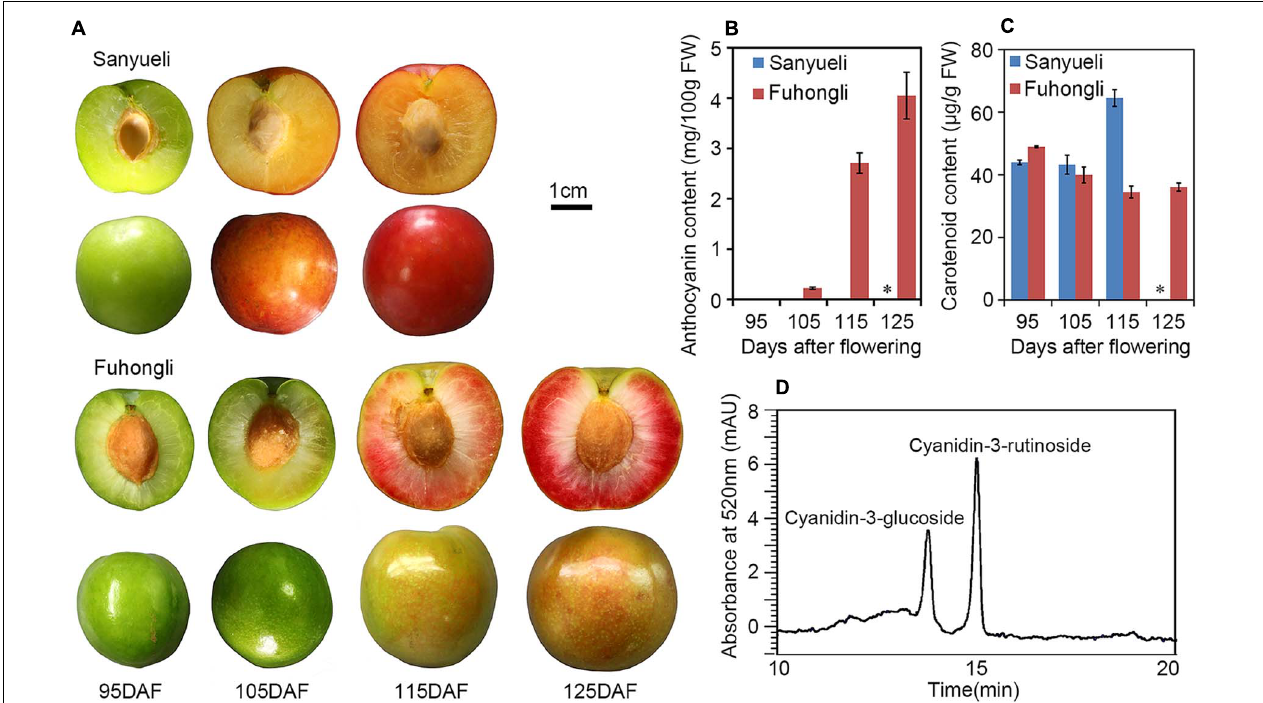
FIGURE 2 | Pigmentation changes during fruit ripening of ‘Sanyueli’ and ‘Fuhongli’ plum. (A) Fruits of ‘Sanyueli’ plum and ‘Fuhongli’ at different stages. (B) Comparison of anthocyanin content in different ripening stages of ‘Sanyueli’ and ‘Fuhongli’. (C) Carotenoid content in different ripening stages of ‘Sanyueli’ and ‘Fuhongli’. (D) HPLC chromatogram of anthocyanins extracted from flesh of ‘Fuhongli’. ∗ indicates there is no value for ‘Sanyueli’ 125 DAF as the fruits ripened earlier. Error bars represent standard error of three